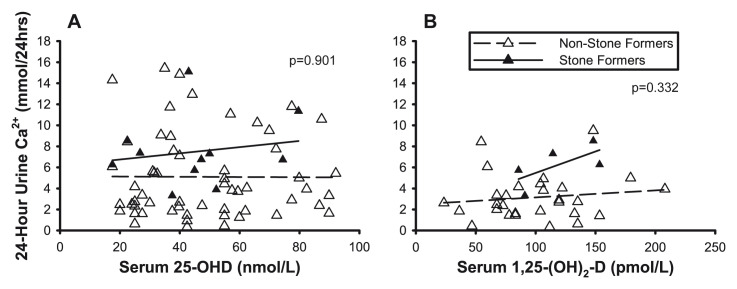
Urinary calcium excretion in non-stone formers and stone-forming subjects with sarcoidosis.Lack of significant relationship of 24 hour urinary calcium with serum 25-hydroxyvitamin-D (25(OH)D) (left panel) and 1,25-dihydroxyvitamin-D (1,25-(OH)2D) (right panel) in patients with sarcoidosis. This figure was reproduced from Vitamin-D status and mineral metabolism in two ethnic populations with sarcoidosis, Capolongo et al., 64, 1025–34, 2020 with permission from BMJ Publishing Group Ltd12.